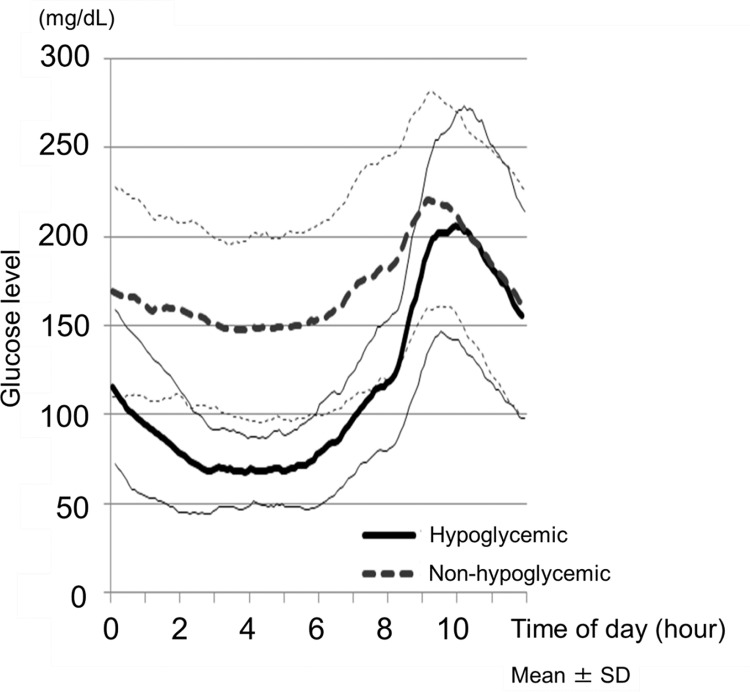
Glucose Profiles Showing Nighttime to Post-Breakfast Glucose levels.Hypoglycemic patients (n = 23); Non-hypoglycemic patients (n = 41).